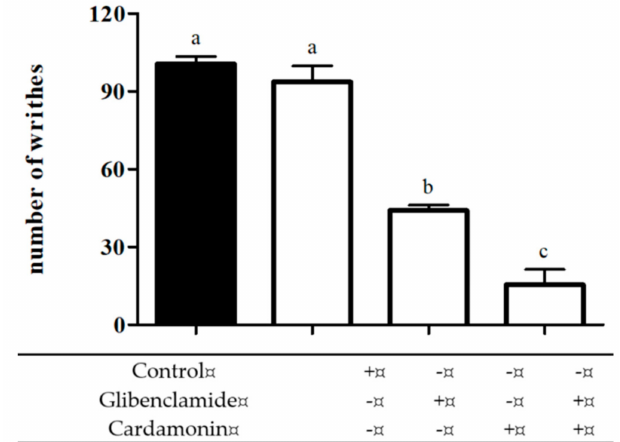
Figure6. E ff ectofglibenclamide(10mg / kg; i.p.)